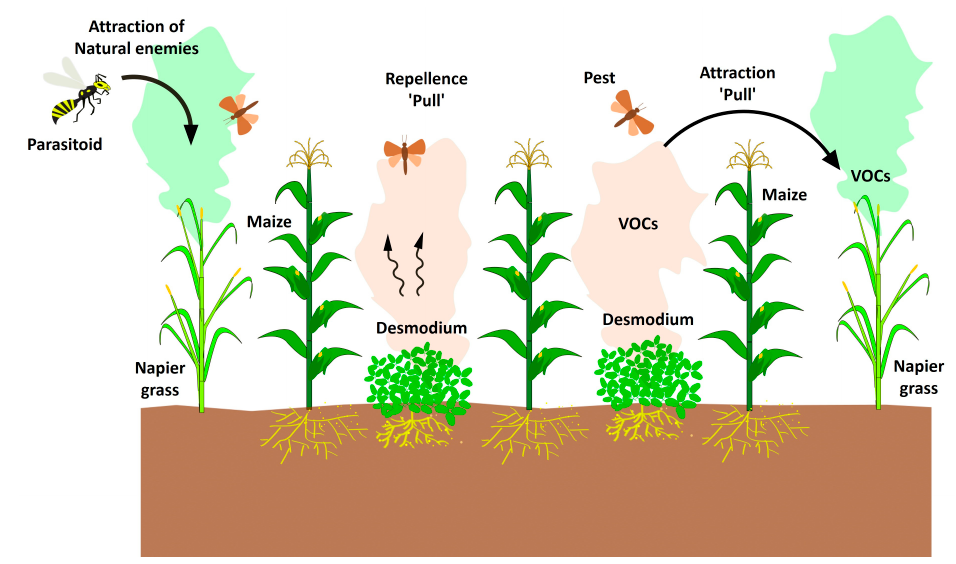
Figure 6. ‘Push–Pull’ system consists of intercropping cereals such as maize ( Zea mays ) with a legume such as Desmodium ( Desmodium uncinatum ), which emits volatiles that repels stemborers moths (‘push’ effect) and is bordered by a trap crop such as Naiper grass ( Pennisetum purpureum ), which attracts stemborers moths (‘pull’ effect). In addition, Desmodium enhances soil quality through nitrogen fixation.